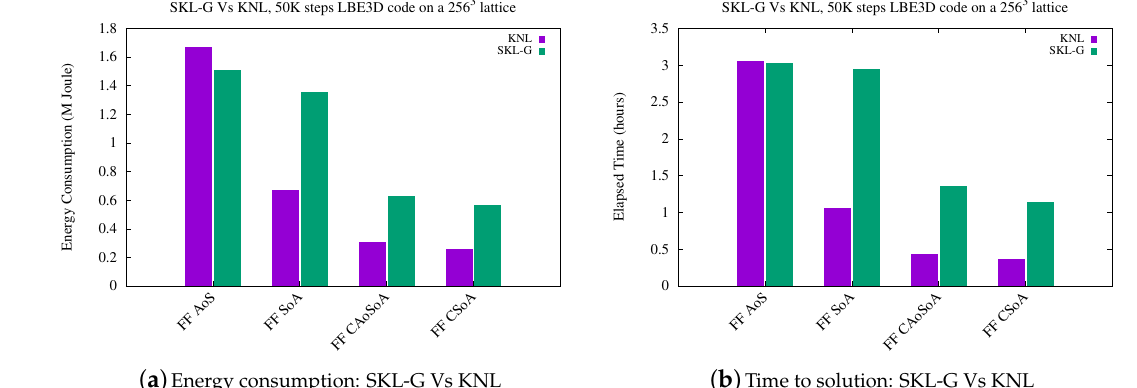
Figure 6. Measure of energy consumption for the LB main loop on SKL-G processor. In ( a ) the measured energy efficiency is reported for 50K time steps of the LB main loop on a 256 3 lattice measuring all considered data layout.